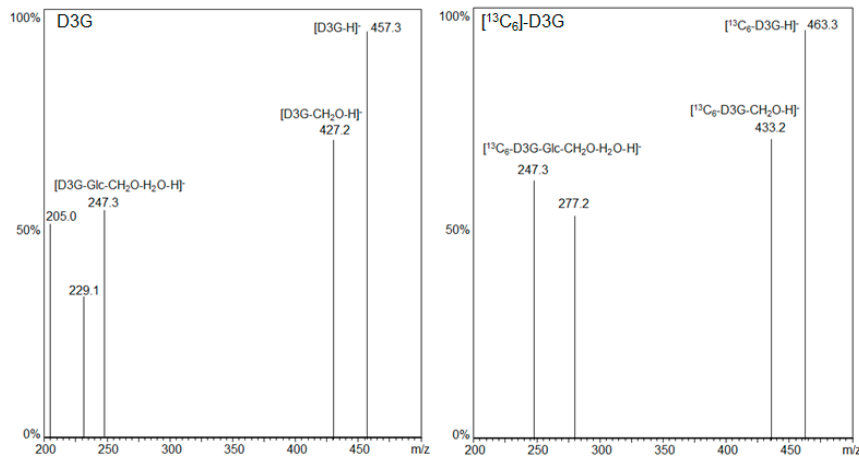
Figure 2. LC-MS/MS fragmentation spectra of D3G and [ 13 C 6 ]-D3G. Table 1. LC-MS/MS parameter of the stable isotope dilution assay of D3G and DON.